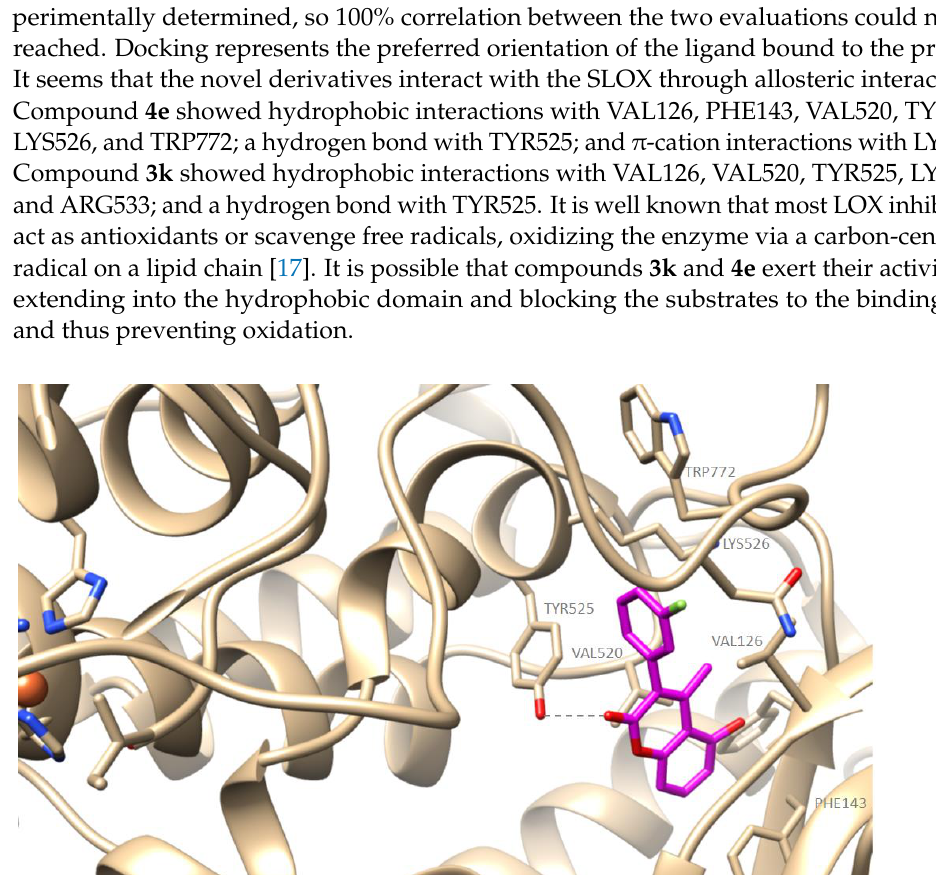
Figure 2. Preferred docking pose of 3k (depicted in cyan) bound to soybean lipoxygenase (LOX-1). 2.5. Cell Viability in Human Epidermal Keratinocyte (HaCaT) Cell Line The MTT assay (3- [4,5-dimethylthiazol-2-yl] -2,5 diphenyl tetrazole) is based on the conversion of MTT to formazan crystals by living cells, which determines mitochondrial activity. Since for most cell populations total mitochondrial activity is related to the number of viable cells, this assay is widely used to measure the in vitro cytotoxic effects of drugs on various cell lines or primary cells. The principle of the MTT assay is that for most viable cells the mitochondrial activity is stable, and therefore, an increase or de- crease in the number of viable cells is linearly related to mitochondrial activity. The mi- tochondrial activity of the cells is reflected by the conversion of the MTT tetrazole salt to formazan crystals (bright purple), which can be solubilized (in this protocol with DMSO) for homogeneous measurement. Thus, any increase or decrease in the number of viable cells can be detected by measuring the formazan concentration reflected in the optical density (OD) measurement at 540 nm with a reference absorption of 720 nm.